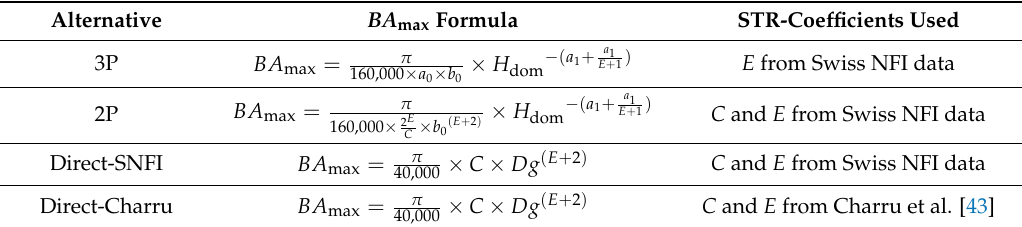
Table 2. Summary of the four alternatives employed to estimate BA max : corresponding formulas and origins of the coefficients